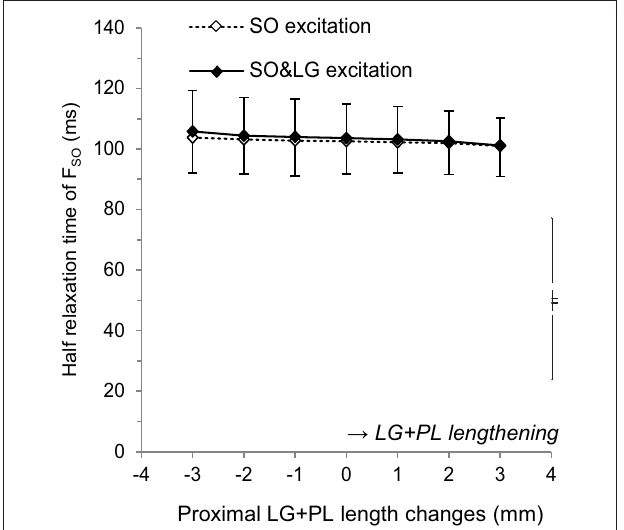
FIGURE 3 | Effects of LG + PL length changes on the half relaxation time of forces exerted at the distal tendon of SO for SO excitation ( ♦ ) and SO&LG excitation ( (cid:7) ). Means ± s.d. are shown ( n = 5).